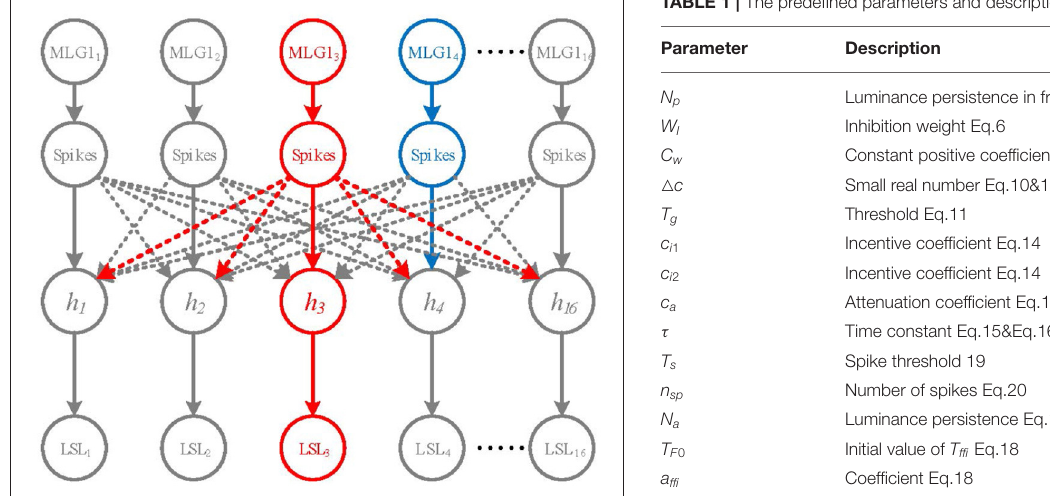
TABLE 1 | The predefined parameters and descriptions of proposed